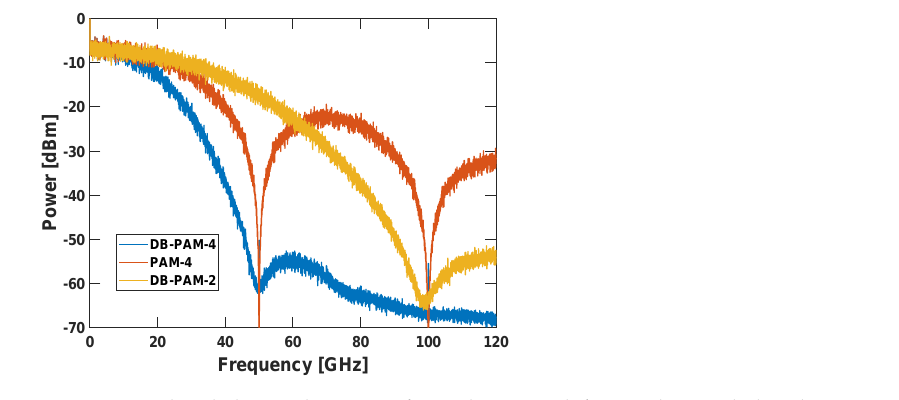
Figure 3. Simulated electrical spectra of noiseless 100 Gb/s signals encoded with DB-PAM-4, PAM-4 and DB modulation